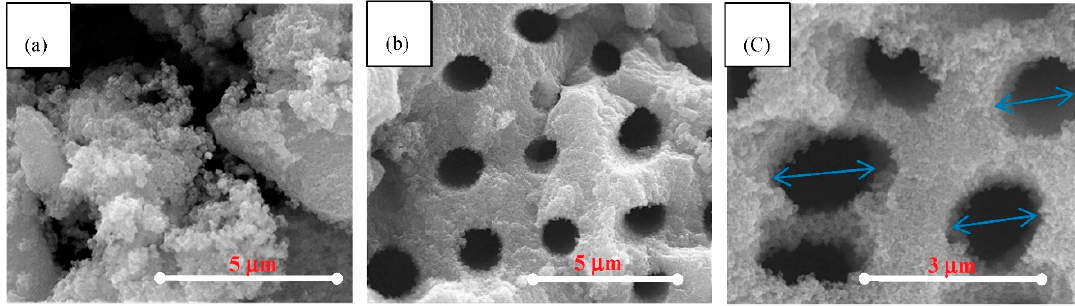
Figure 3. SEM micrographs of the as synthesized TiO 2 nanomaterials prepared without CHE ( a ) and with CHE ( b , c ).